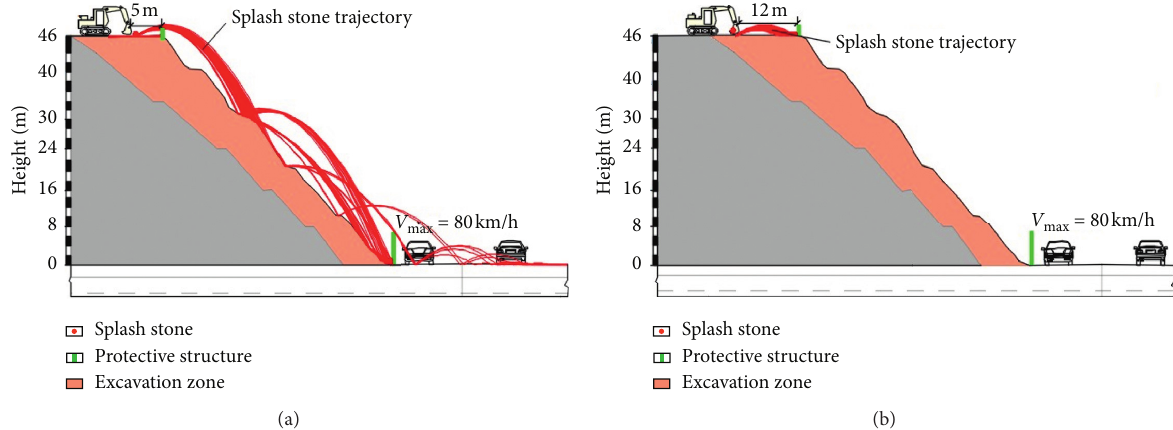
Figure 10: Splash stone trajectory of different distance (a) 5m from the protective structure (b) 12m from the protective structure.